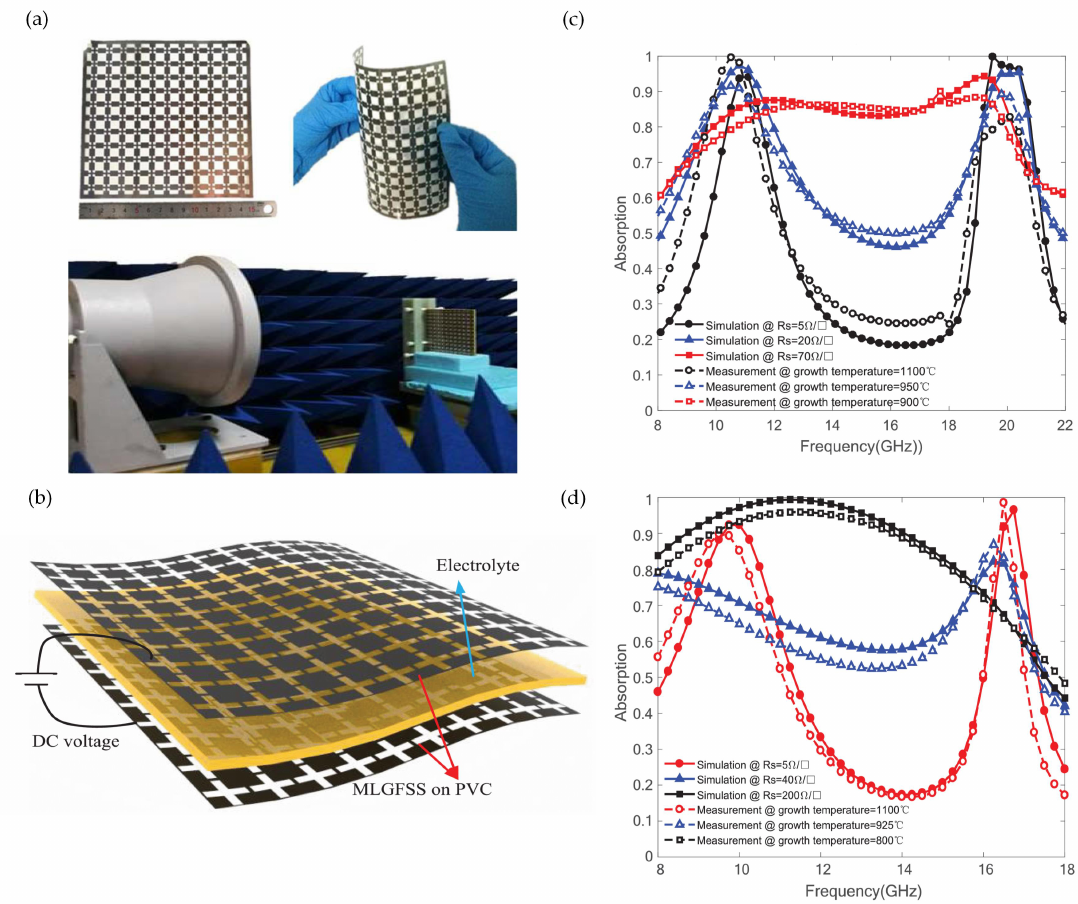
Figure 12. ( a ) image of the fabricated Type-A sample and measurement setup; ( b ) measured and simulated absorption spectra of Type-A metasurface with various graphene sheet resistances; ( c ) schematic of Type-B sample; ( d ) measured and simulated absorption spectra of Type-B metasurface with various graphene sheet resistances, reprinted with permission from Ref.